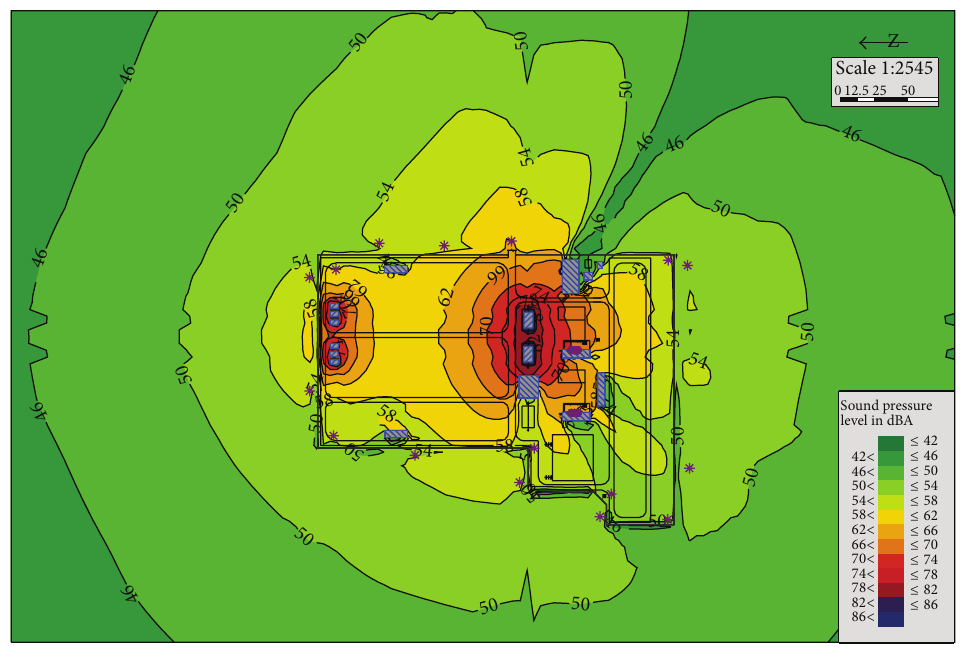
Figure 3: Substation noise distribution in Plan A.